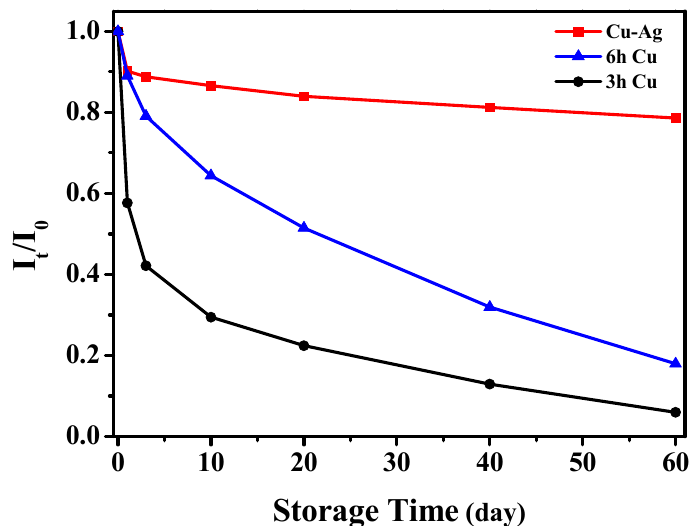
Figure 5. Endurances of SERS performances of various SERS chips to the air oxidation during storage: Cu(3 h) chip, Cu(6 h) chip and Cu-Ag chip.